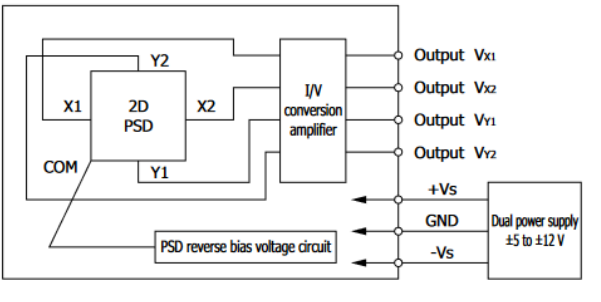
Figure 2. C10443-01 sensor block diagram [14].